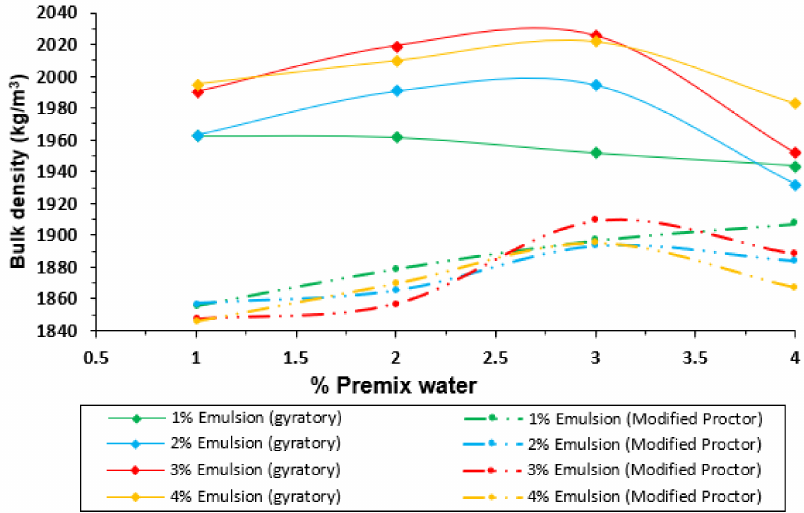
Figure 6. Comparison of bulk density for different emulsion content in samples compacted with the gyratory compactor and modified Proctor